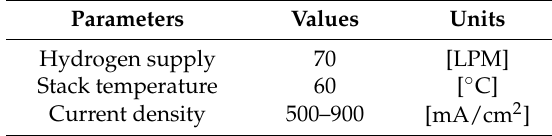
Table 4. Characteristic experimental conditions of fuel cell.